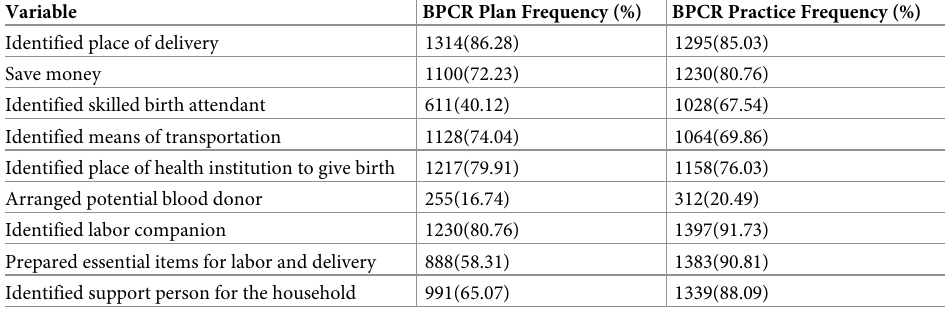
Table 3. Individual BPCR plan and practice among the cohort of pregnant women in North Gondar Zone, North- west Ethiopia, 2018 (n =